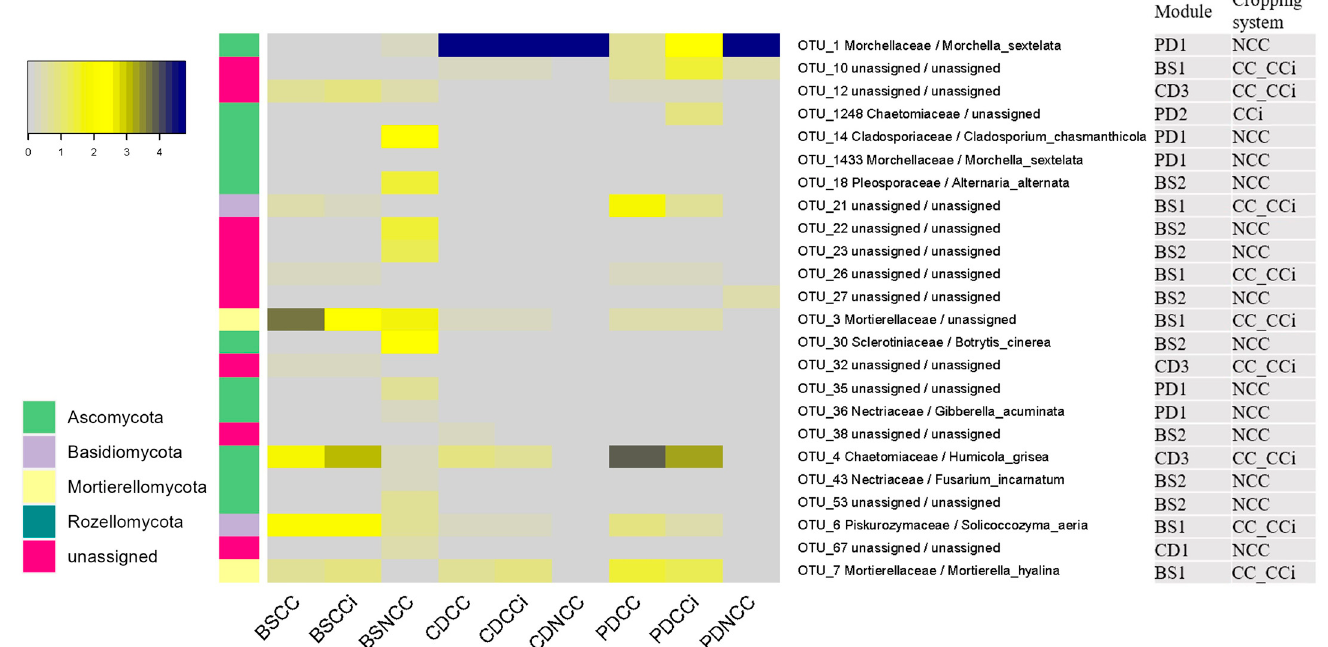
Figure 5. Mean relative abundances of cropping-sensitive OTUs identified by indicator species analysis. OTUs are labeled with their family/species level taxonomy assignment, with the phylum level taxonomy assignment indicated by the colored bars.